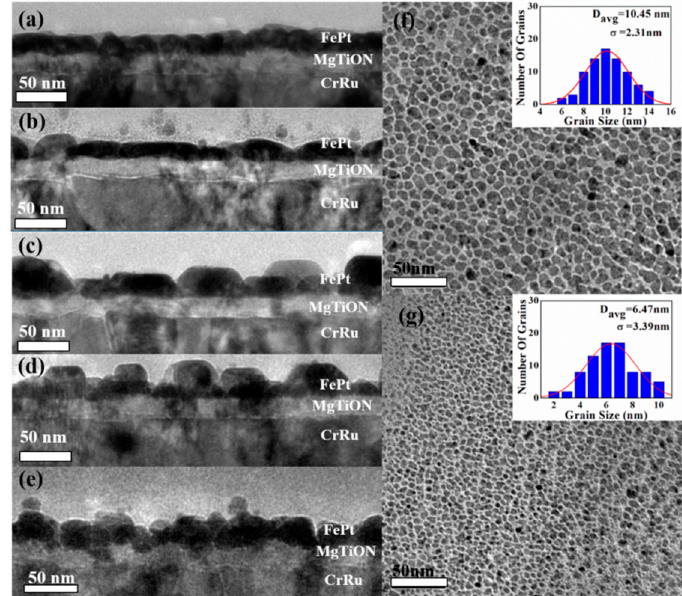
Figure 6. Cross-section TEM images of representative samples from series (II), ( a ) x = 0; ( b ) x = 10; ( c ) x = 20; ( d ) x = 30; ( e ) x = 40; plan-view iamges of samples ( f ) x = 20; ( g ) x = 40.